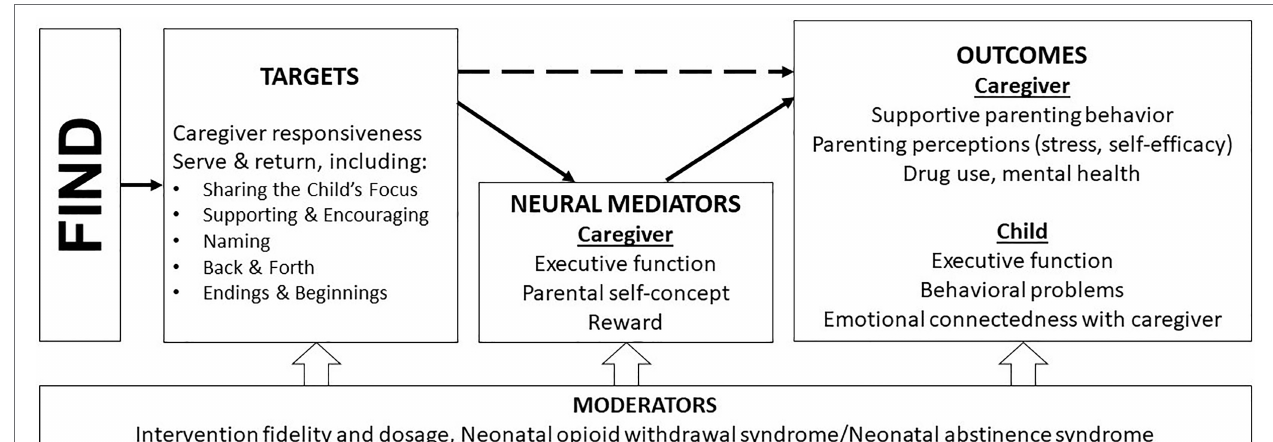
FIGURE 2 | FIND conceptual